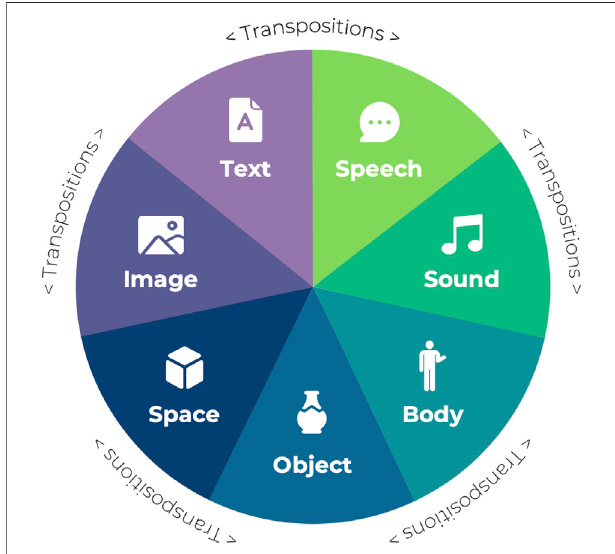
FIGURE 2 | Transpositions between forms of meaning (Cope and Kalantzi, in